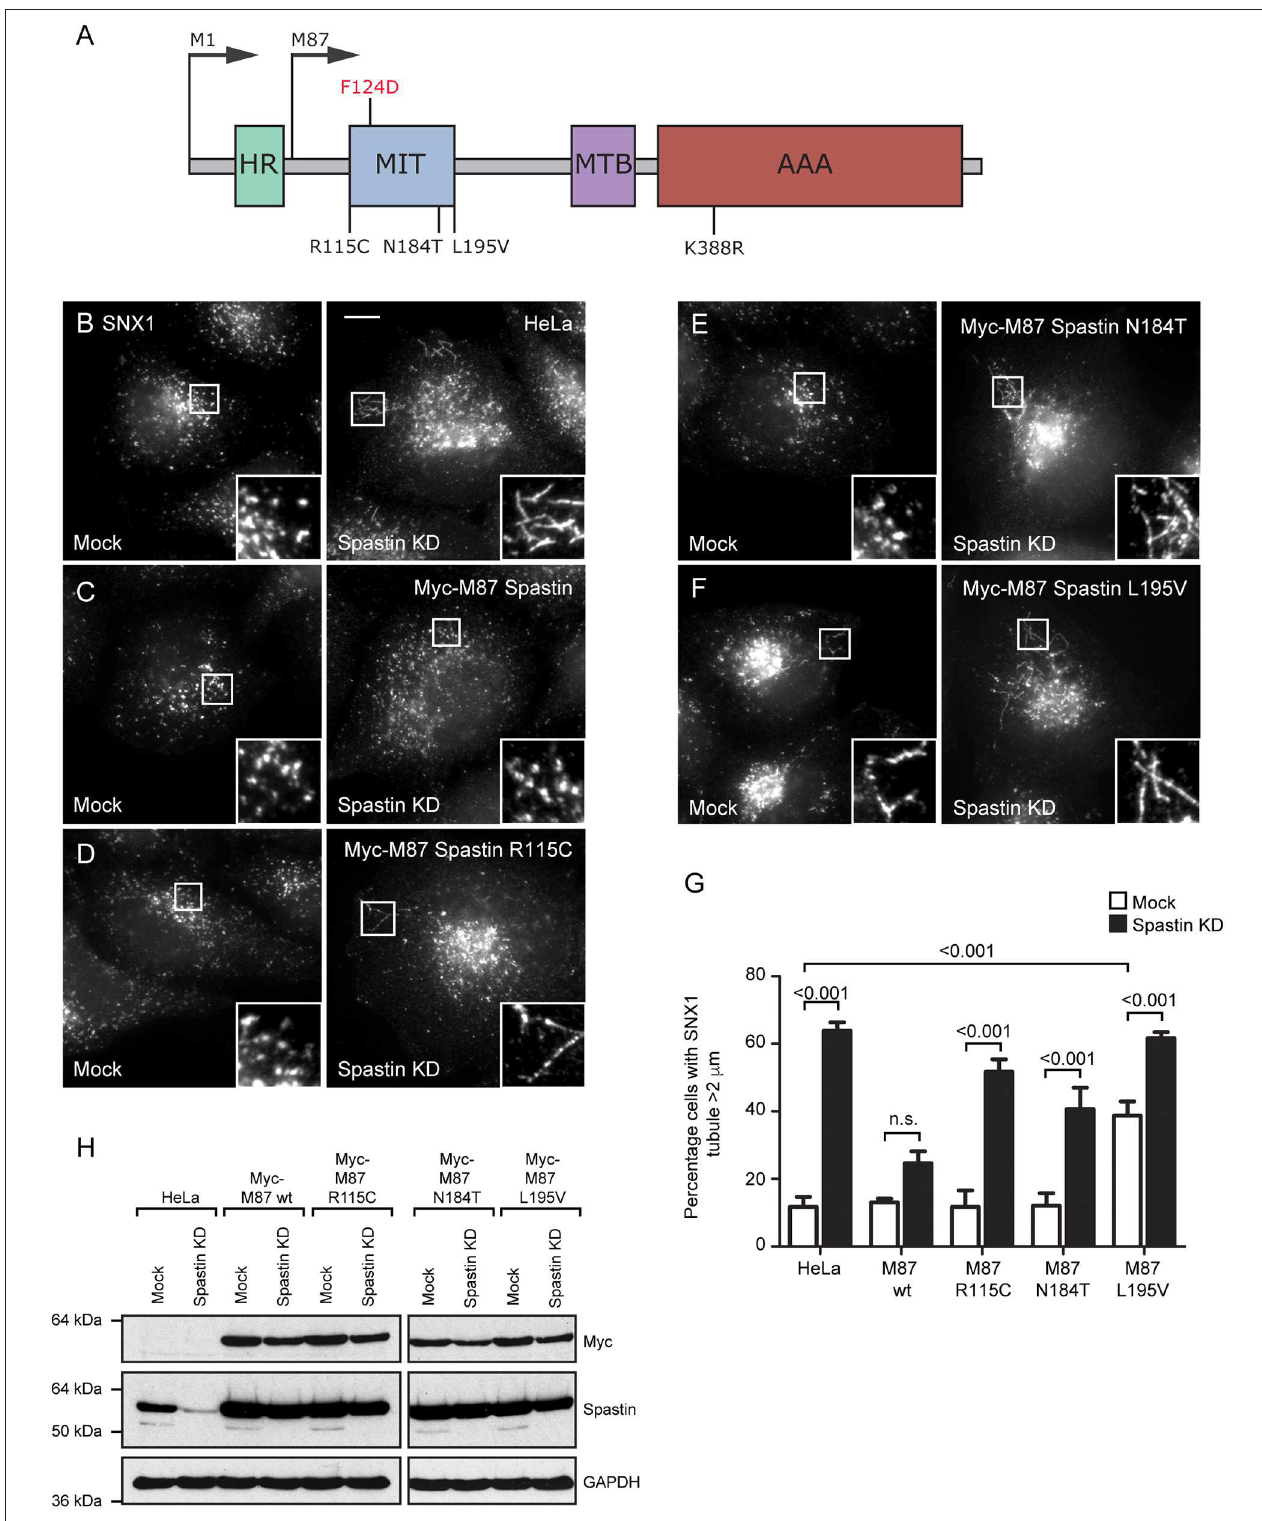
FIGURE 1 | Disease-associated spastin MIT mutants cannot support normal endosomal tubule fission. (A) Schematic diagram of spastin’s domain structure, annotated with the position of artificial (above) and disease-associated (below) mutants used in this study. HR, hydrophobic region; MIT, MIT domain; MTB, microtubule binding domain; AAA, ATPase domain. (B–F) Wild-type HeLa cells or cells expressing the siRNA-resistant spastin constructs indicated were subjected to